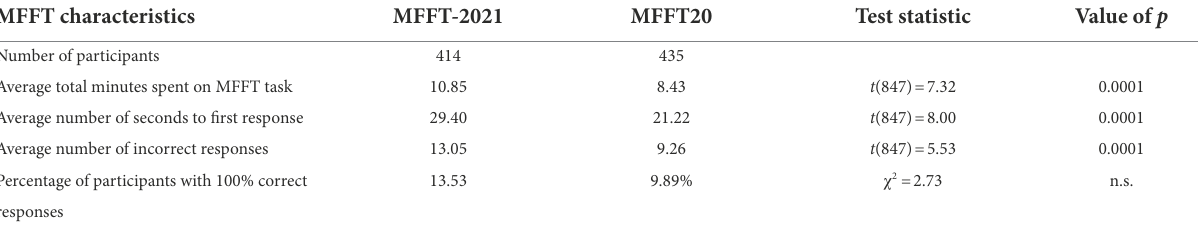
TABLE 1 Comparison of MFFT response characteristics by